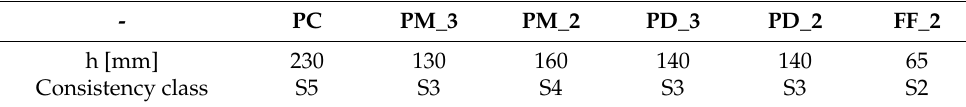
Figure 1. Slump test for concrete mixes: ( a ) PC; ( b ) PM_3; ( c ) PM_2; ( d ) PD_3; ( e ) PD_2; ( f ) FF_2. Table 5. Slump classification according to EN 12350-2